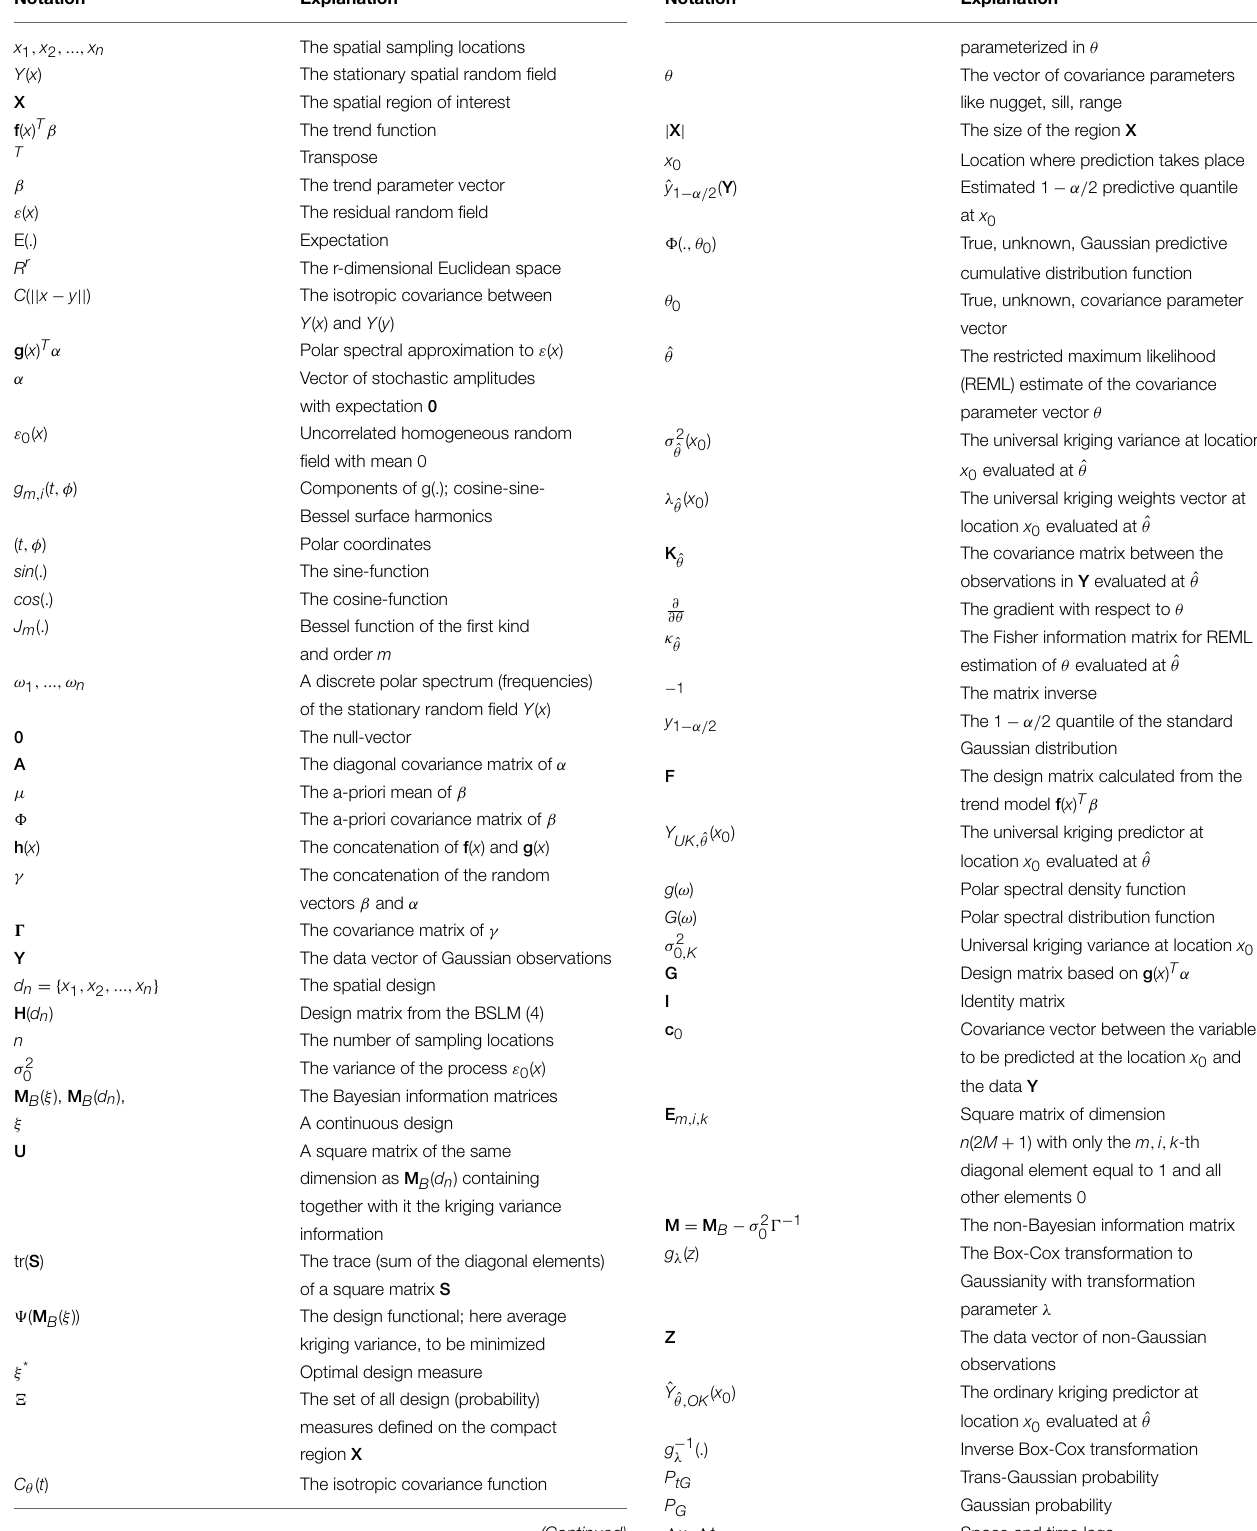
TABLE 1 | Notations sorted in order of